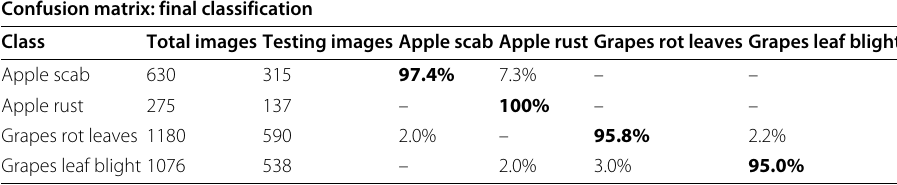
Table 13 Confusion matrix of the final classification Confusion matrix: final